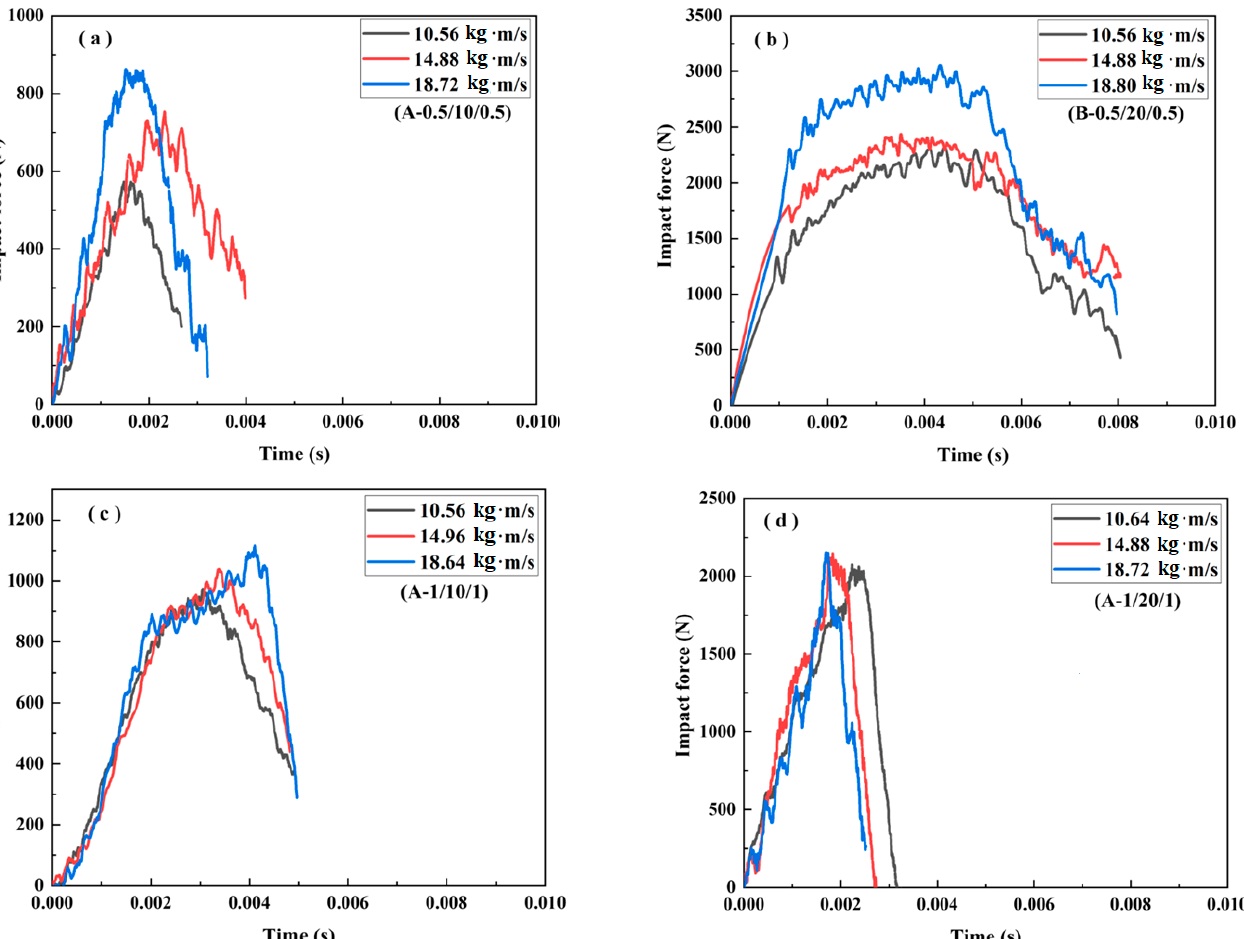
Figure 4. Effects of the density and thickness of the core and face sheet on: ( a ) crush force efficiency; ( b ) energy absorption; ( c ) specific energy absorption.